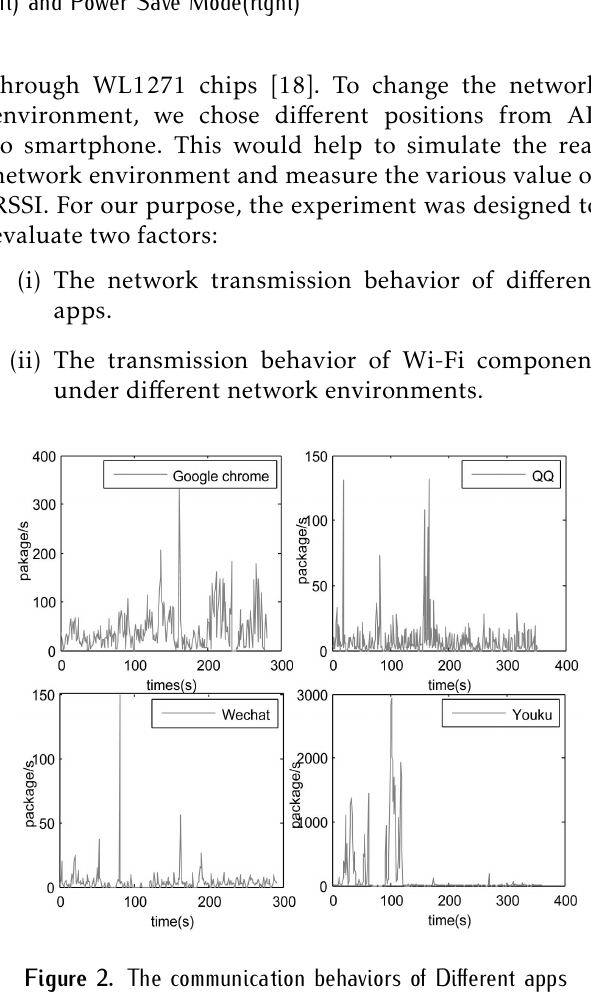
Figure 2. The communication behaviors of Different Fig. 2 . (a)The communication behaviors of Different apps